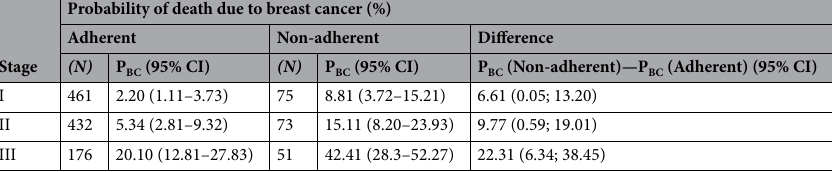
Table 3. Ten-year cumulative crude probabilities of death due to breast cancer in the cohort, according to stage at diagnosis. P BC Probability of death due to Breast Cancer; 95% CI: 95% Confidence